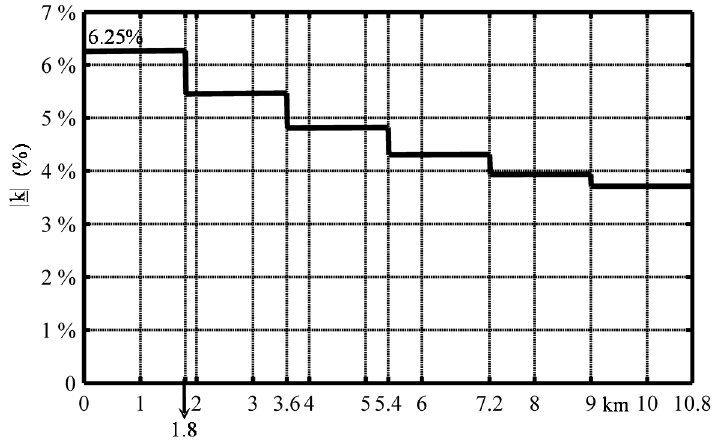
Figure 14. Behaviour of the k -factor percentage along the line by means of